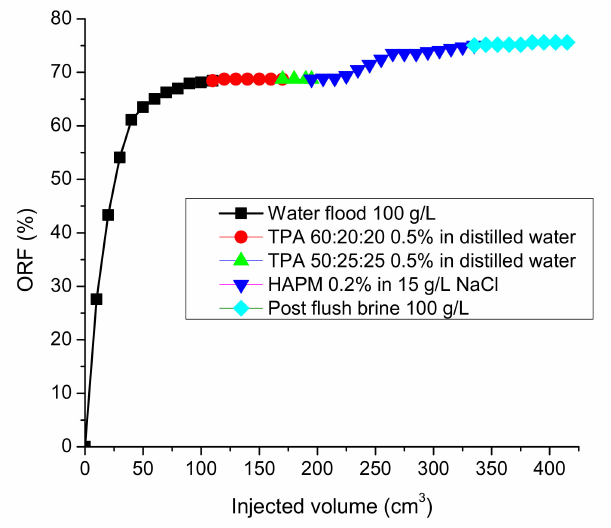
Figure 8. Oil recovery factor versus injected volume, with flow rate set at 0.1 cm 3 /min.